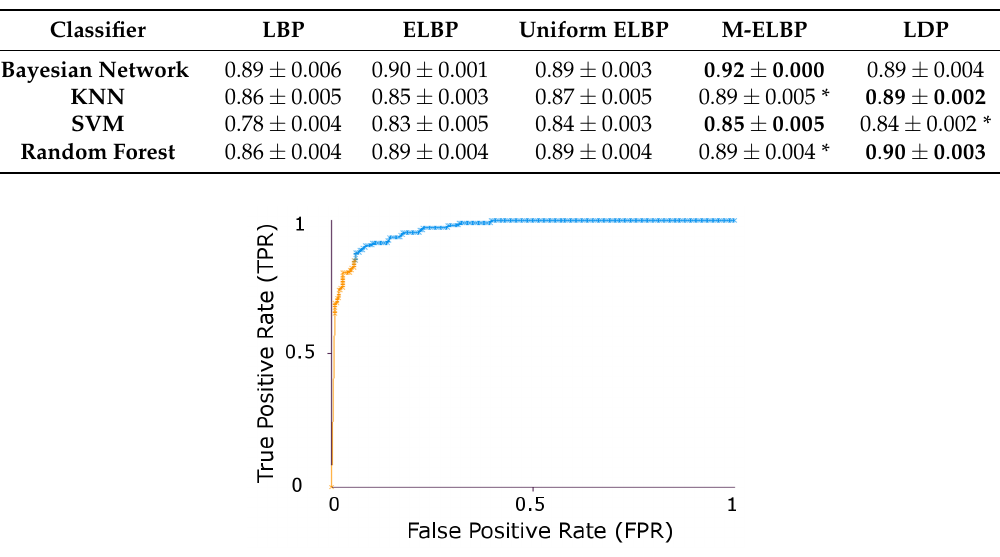
Figure 6. ROC curve for M-ELBP for a Bayesian